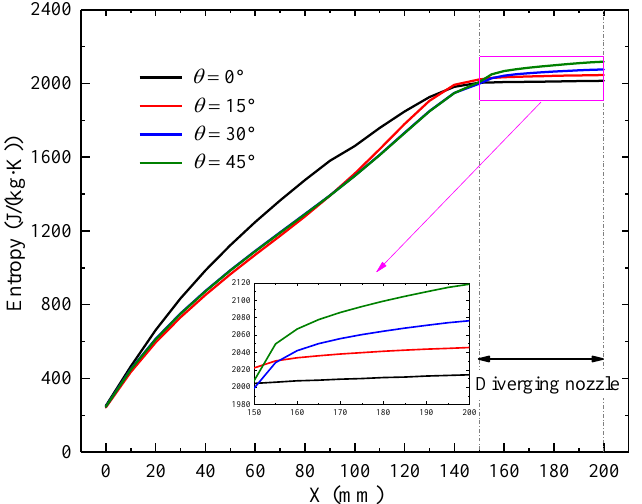
Figure 16. Entropy in different axial cross-sections of the RDC at t = 3980 μs.